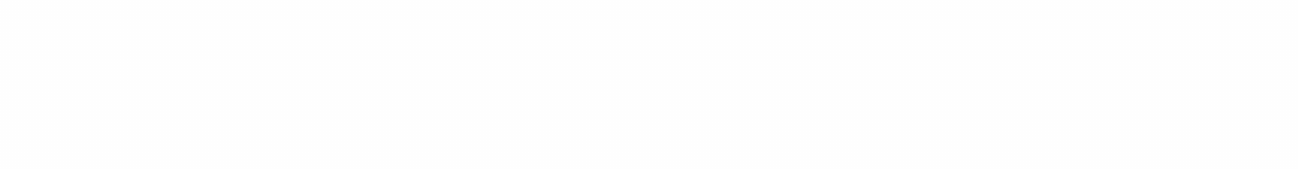
FIGURE 5 The transformation of the closed invariant curve represented in Figure 3 into the attracting set represented in Figure 4 is related to the appearance of "periodic windows" observed as c increases. A particular cycle of period-16 is represented in (a) for c=0.57765, which undergoes the usual flip-cascade leading to chaotic motion. Figure (b), obtained for c=0.5777, shows a cycle of double period and (c) for c 0.57781 shows cyclical chaotic pieces of period-16, which are disjoint, as evidenced in the enlargement in